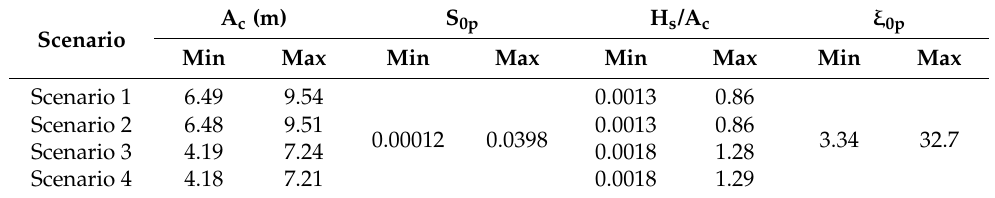
Table 5. Parameter range for all the studied cases.